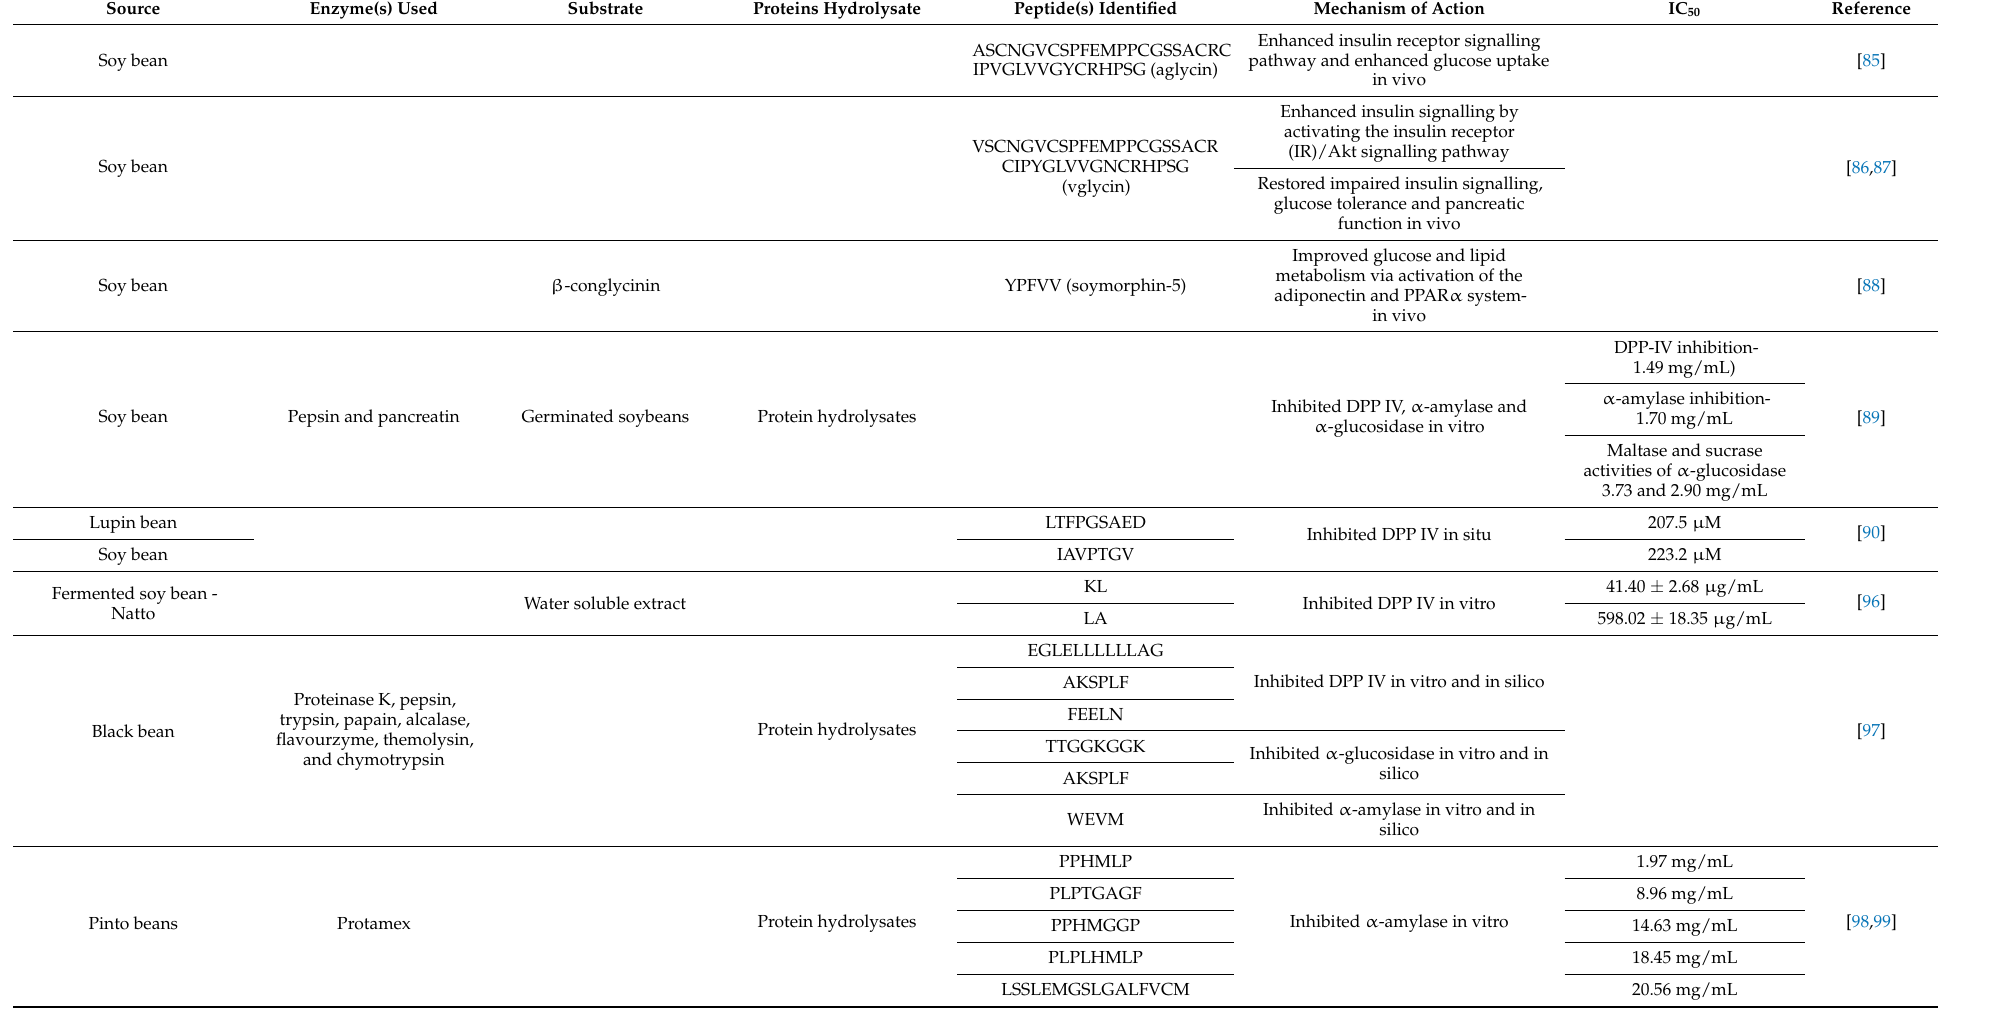
Table 3. Antidiabetic action of peptides and protein hydrolysates identified from plant food